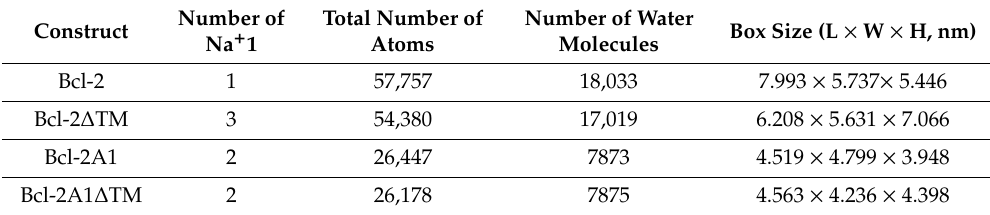
Table 2. System data for each construct used in molecular dynamics